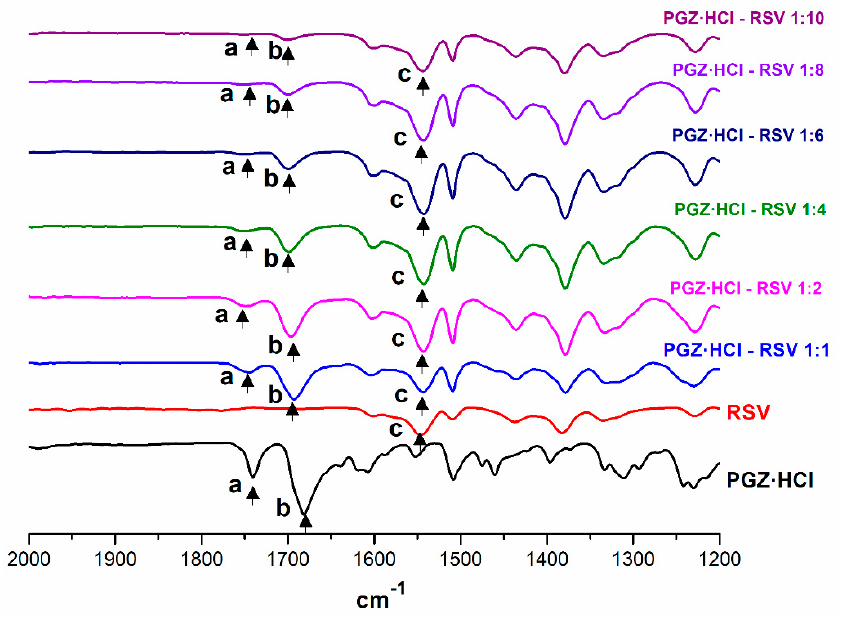
Figure 7. Expanded FT-IR spectra of the solid forms of PGZ·HCl-RSV at different stoichiometric ratios (1:1, 1:2, 1:4, 1:6, 1:8, and 1:10).